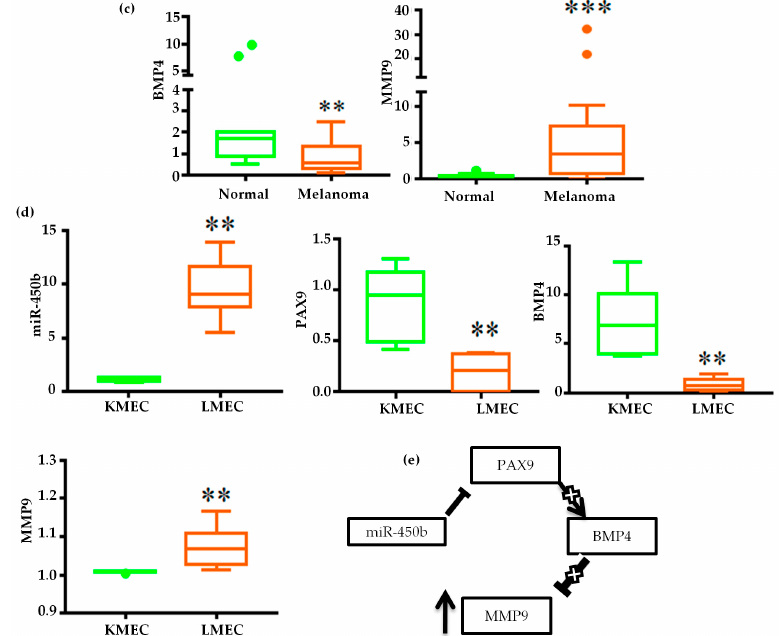
Figure 3. Gene regulatory function of miR-450b, miR-301a, and miR-223: ( a ) Relative expression of the target genes PAX9 , NDRG2 , and ACVR2A . Y-axes indicates the relative mRNA expression normalized against GAPDH , ( b ) Spearman correlation of the expression of the miR-450b- PAX9 , miR-301a- NDRG2 , and miR-223- ACVR2A pairs, ( c ) Relative expression of BMP4 and MMP9 in melanoma tissue samples, ( d ) Relative expression of miR-450b, PAX9 , BMP4 , and MMP9 in the canine melanoma cell lines KMEC and LMEC. Mann-Whitney test followed by Tukey’s test, * p <